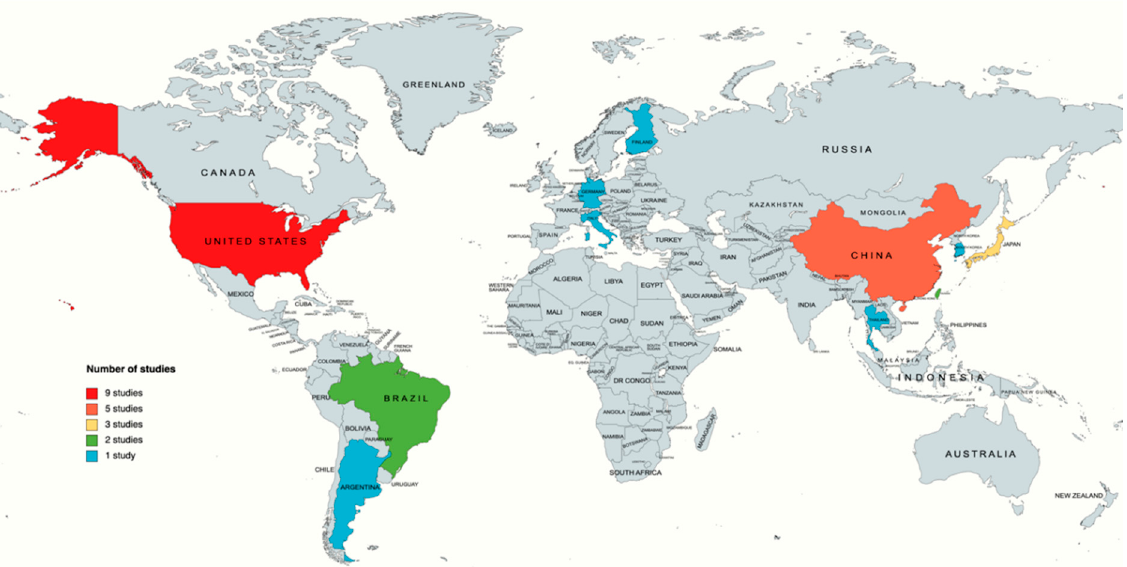
Figure 2. Geographic distribution of the retrieved publication studying stem cell image analysis using artificial intelligence.